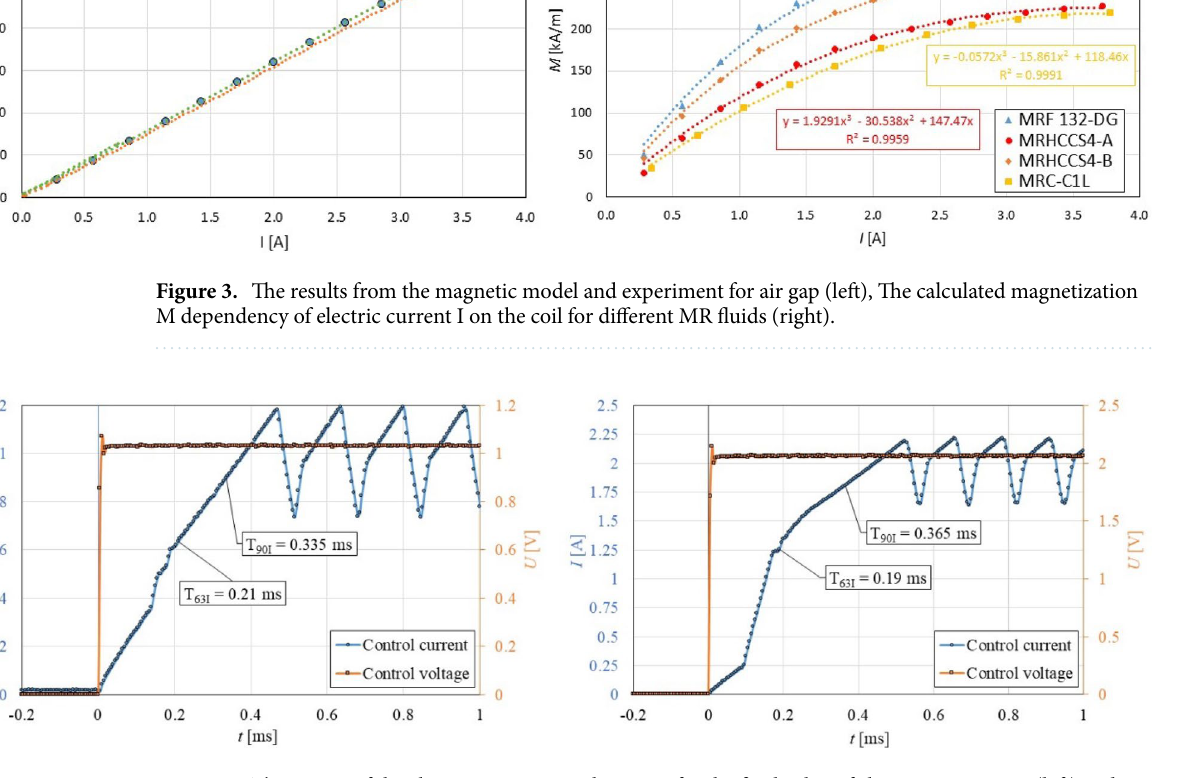
Figure 4. The course of the electric current I in the time t for the final value of electric current 1 A (left) and 2 A